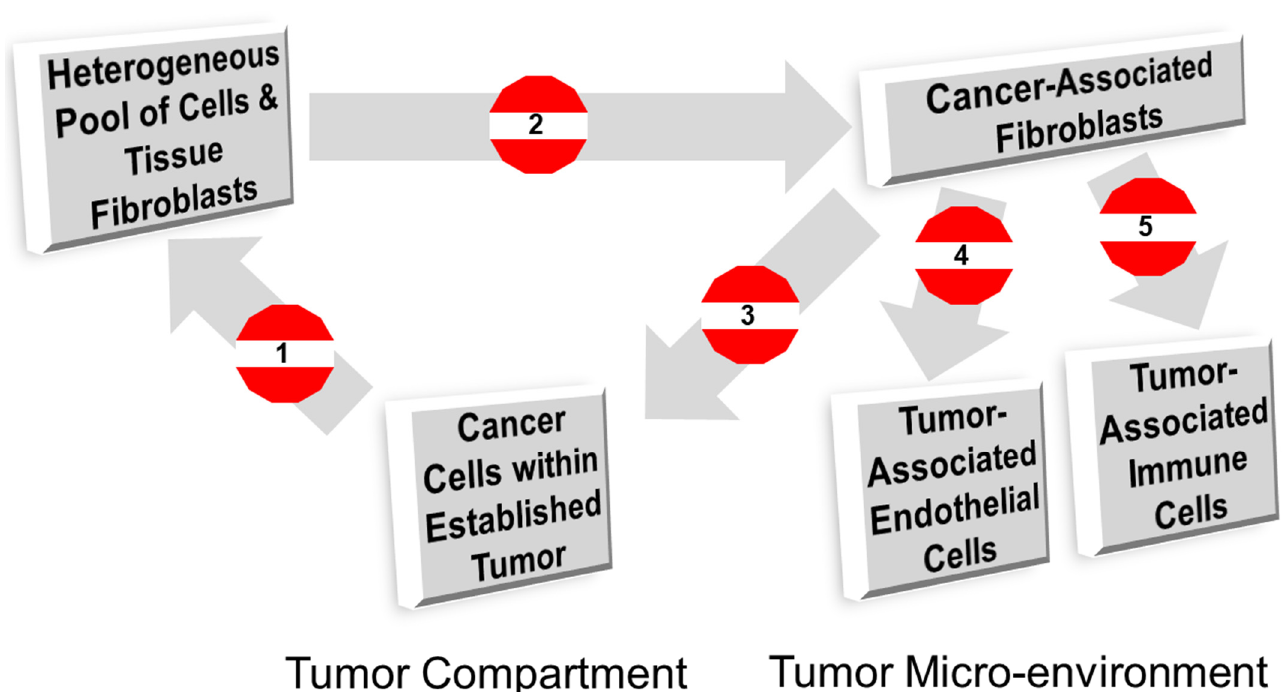
Figure 3. Strategic opportunities to regulate CAF functions in an established or progressing solid tumor. The strategic points to control the function of CAFs are (1) prevention of activation of CAFs by targeting or counteracting signals from tumor cells, (2) regulating the activation of CAFs by targeting the CAF population directly, (3) regulating the pro-tumorigenic signals from CAFs, (4) regulating the pro-angiogenic signals from CAFs, and (5) regulating the pro-immune evasion and anti-immune surveillance signals from CAFs. These strategic points represent ‘action items’ to ‘switch off’ the pro-resistance CAFs within the tumor stroma.